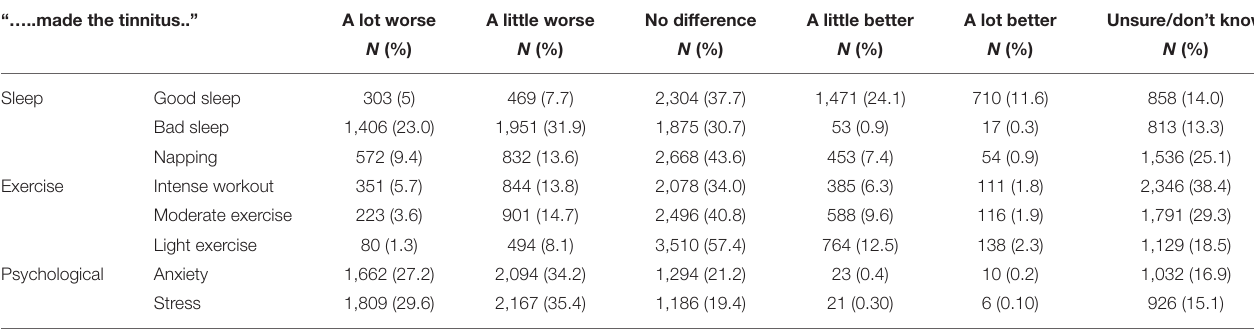
TABLE 4 | Effect of physical and psychological factors on experienced tinnitus out of survey physical links ( n = 6,115). “…..made the